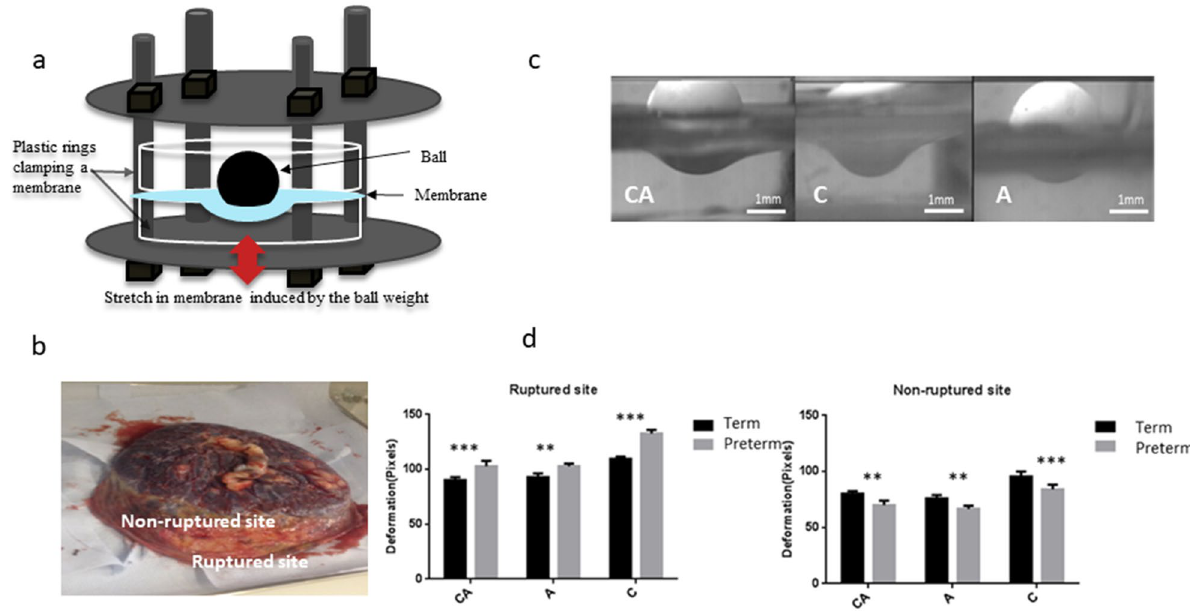
Figure 1. Ball indentation test of mechanical behaviours of fetal membranes. ( a ) Schematic drawing of ball indentation working principle. ( b ) The image demonstrating the locations of the rupture site (tear area) and non-ruptured site (area far from rupture site or close to umbilical cord). ( c ) Representative displacement images of the membranes following loading for 4 h. CA chorioamnion, C chorion and A amnion. Scale bar is 1 mm. ( d ) Quantification of the displacement following loading for 4 h for ruptured and non-ruptured membranes between preterm and term samples. (n = 4). Data are presented as mean ± SD. ** p < 0.01, *** p <